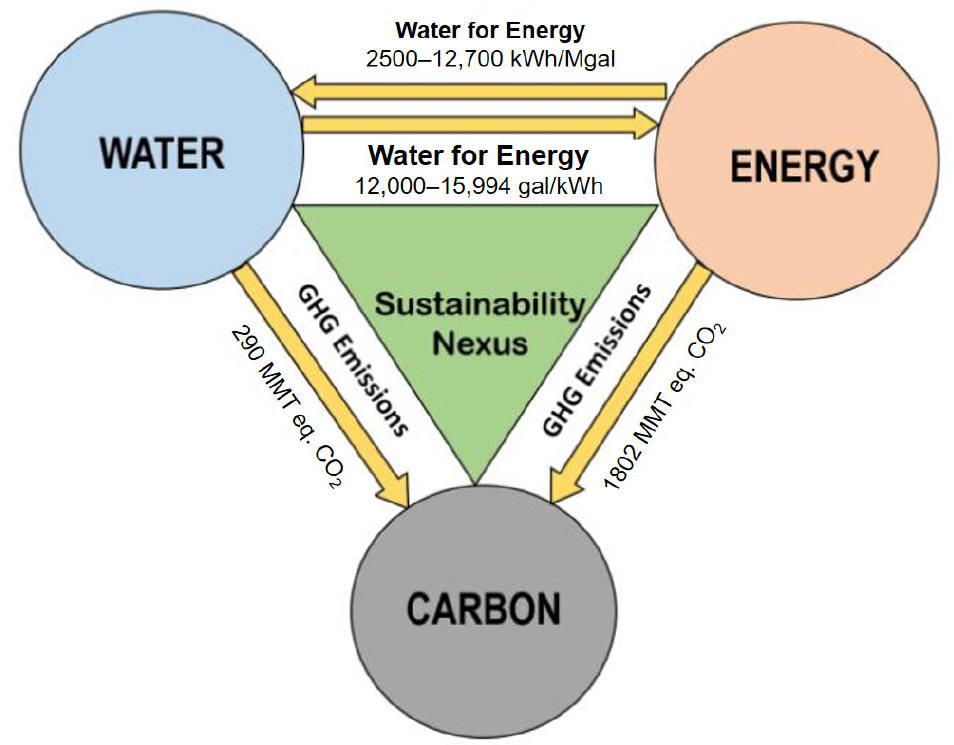
Figure 3. Water-energy-carbon nexus for the United States, 2019 [22]. In this figure, gal, Mgal and MMT represent U.S. Gallons, U.S. Million Gallons and Million Metric Tons respectively.